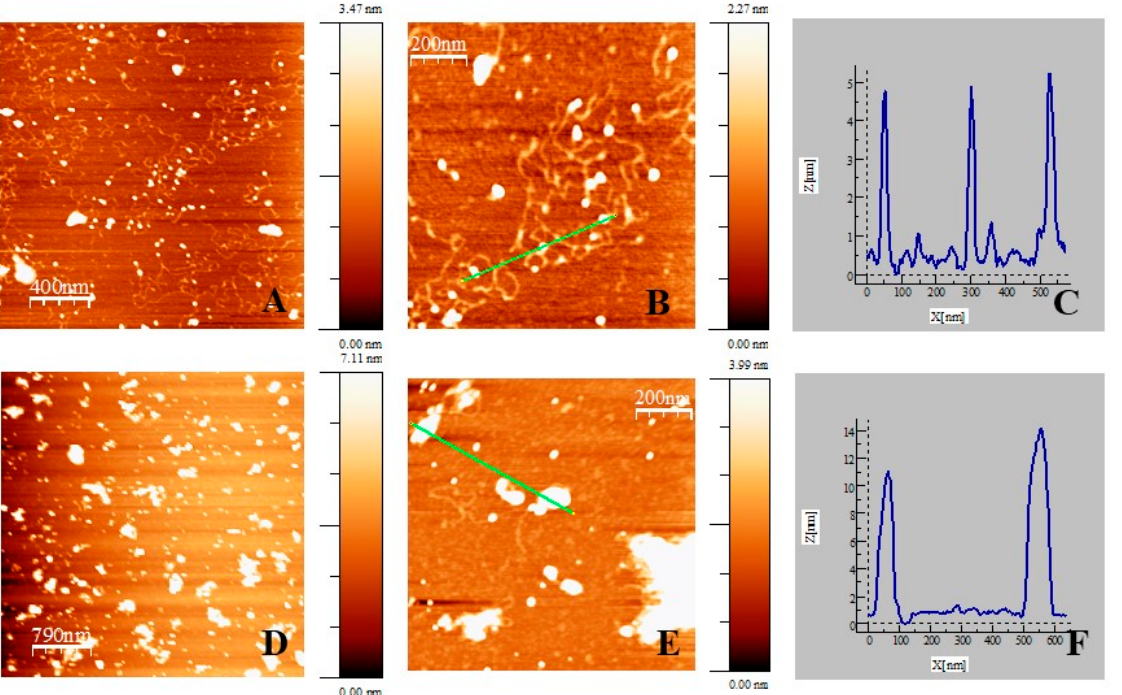
Figure 7. AFM topography images of Au@16-3-16/DNA/SDS and Au@16-6-16/DNA/SDS systems adsorbed on APTES-modified mica surface under Au@16-s-16 disaggregation conditions, and the corresponding size distribution of Au@16-s-16 nanoparticles along the selected lines. Reactant concentrations used were: C Au@16-3-16 = 1.74 × 10 − 8 M, C Au@16-6-16 = 1.38 × 10 − 8 M, C SDS = 30 µM, and C DNA = 1.0 × 10 − 5 M. ( A – C ) Au@16-3-16/DNA/SDS system. ( D – F ) Au@16-6-16/DNA/SDS system (addition method B).